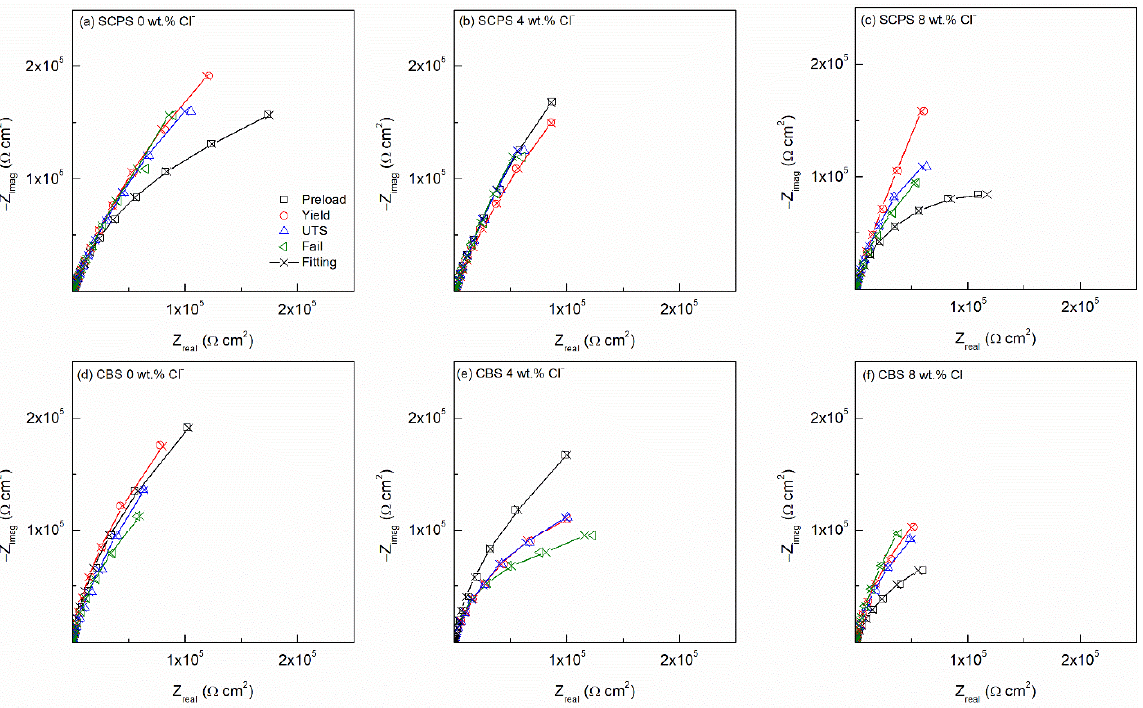
Figure 4. Nyquist plots of UNS S32205 reinforcement during slow strain rate test (SSRT): ( a ) SCPS 0 wt.% Cl – , ( b ) SCPS 4 wt.% Cl – , ( c ) SCPS 8 wt.% Cl – , ( d ) CBS 0 wt.% Cl – , ( e ) CBS 4 wt.% Cl – , and ( f ) CBS 8 wt.% Cl – .